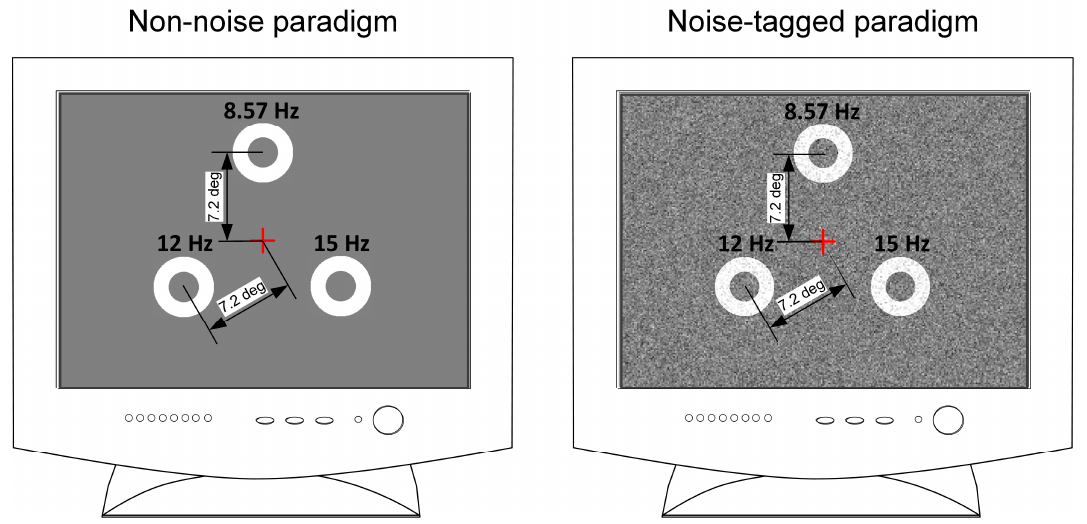
Figure 1. Distribution of three noise masked targets on the computer screen with noise standard deviations of 0 and 40. The cross indicating the center of the monitor was not presented on the screen. The eccentricity from the center of the monitor to that of each target was in a visual angle of 7.2°.